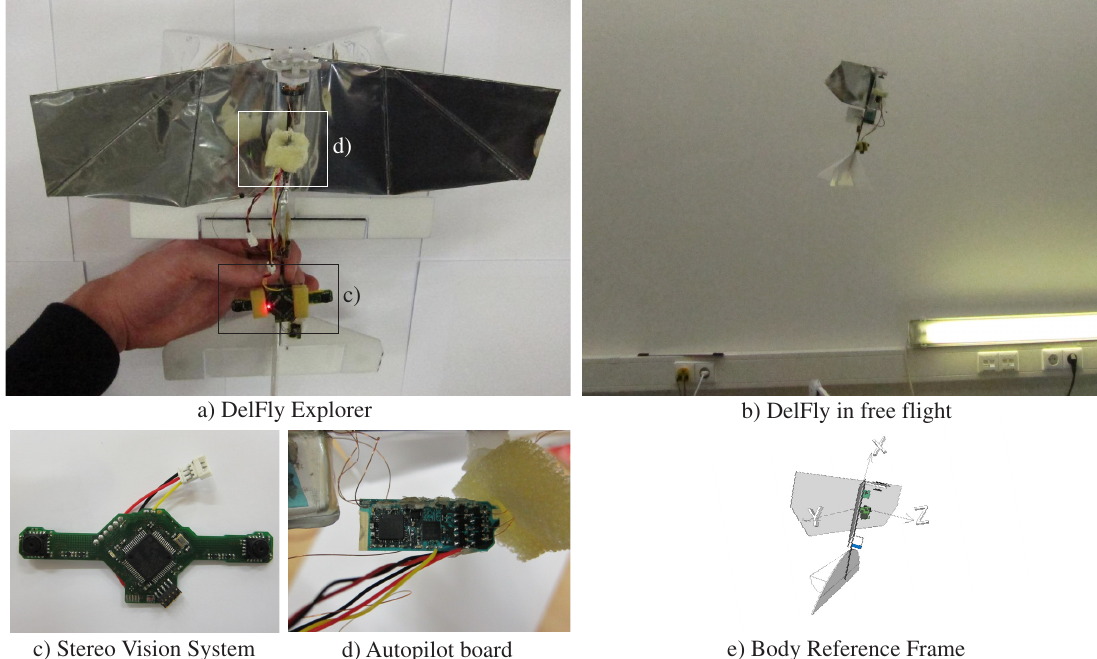
Figure 1. Overview of the DelFly Explorer. ( a ) shows the 28-cm wingspan 20-g FWMAV in detail; ( b ) shows the DelFly Explorer during slow forward flight and visualizes the high pitch angle at this speed; ( c ) shows a close-up of the four-gram stereo vision system. It uses a Complex Programmable Logic Device (CPLD) to merge images and an STM32F4 to process the images; ( d ) shows a close-up of the 0.9-g autopilot board; the autopilot uses an 8-bit micro-controller and MPU9050 IMU; ( e ) shows the definition of the body axes of the